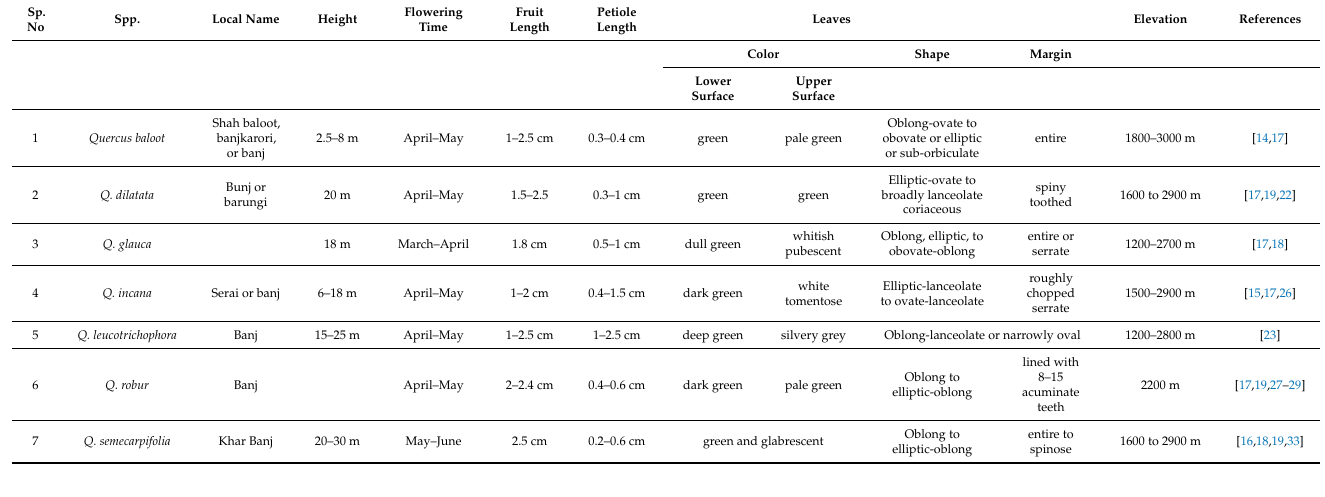
Table 1. Comparative morphological descriptions of seven oak species found in Pakistan.